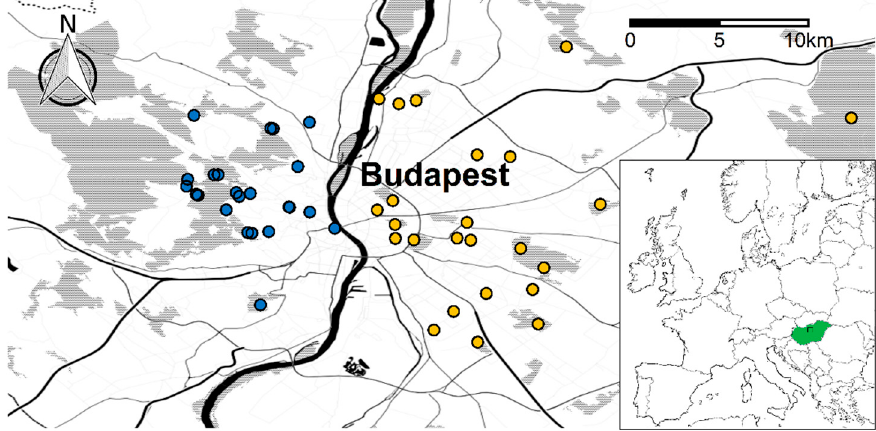
Figure 1. Locations of the sampling sites on the Buda ( N = 23, blue dots) and Pest sides ( N = 24, yellow dots) of Budapest. Inset: Map of Europe showing the position of Hungary and Budapest.